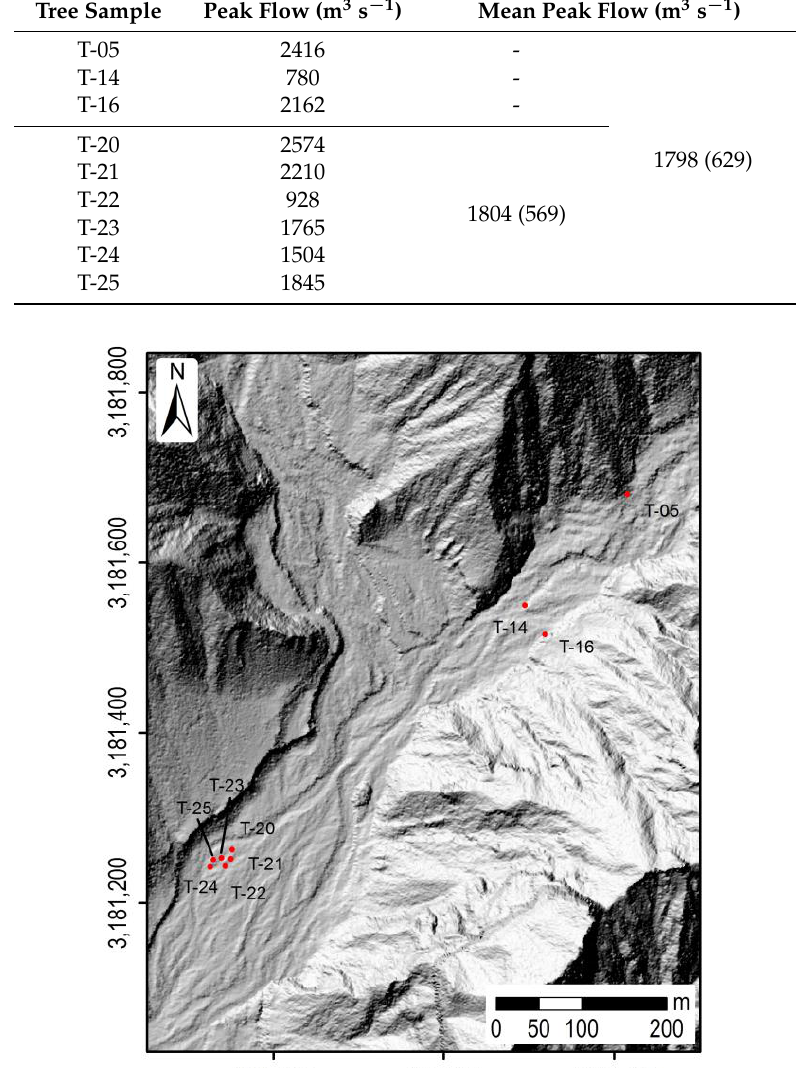
Figure 6. Location of dendro-geomorphological evidence for 1997 flood event. Table 4. Peak flow values (Manning ’ s formula) linked to 1997 flood event dendro-geomorphological evidence.